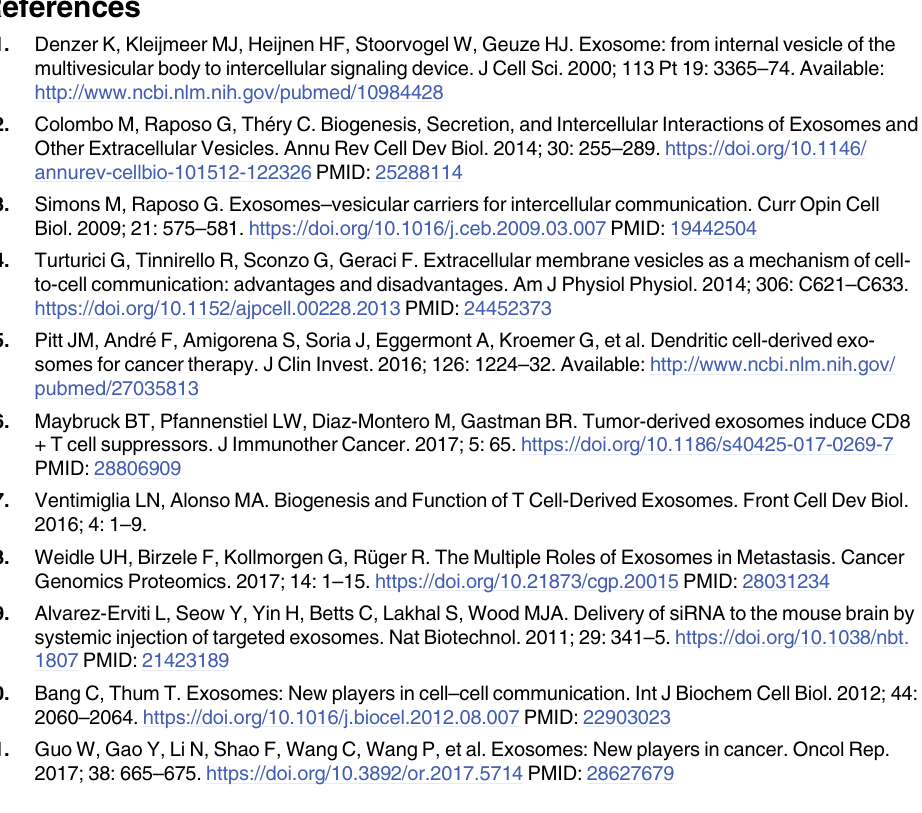
S3 Fig. Loading of pro-productive miRNA-30a into exosomes via overexpression in CAP cells. (A) Size distribution of isolated exosomes from miRNA-30a overexpressing CAP cells measured via dynamic light scattering. (B) GFP-positive exosomes isolated from miRNA-30a overexpression CAP cells measured via flow cytometry. (C) miRNA-30a overexpression in CAP cells and exosomes. (D) Growth behavior of miRNA-30a overexpression CAP cells. (E) Viability of CAP cells overexpressing miRNA-30a.